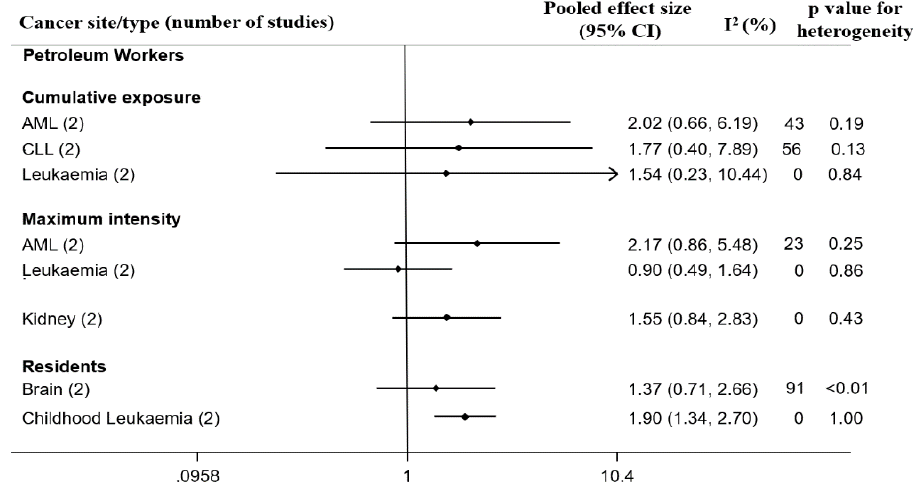
Figure 4. Forest plot of pooled effect sizes and heterogeneity in nested case-control studies evaluating cancer among petroleum industry workers and case-control studies evaluating cancer risk among residents living in proximity to petroleum facilities sorted by ICD.